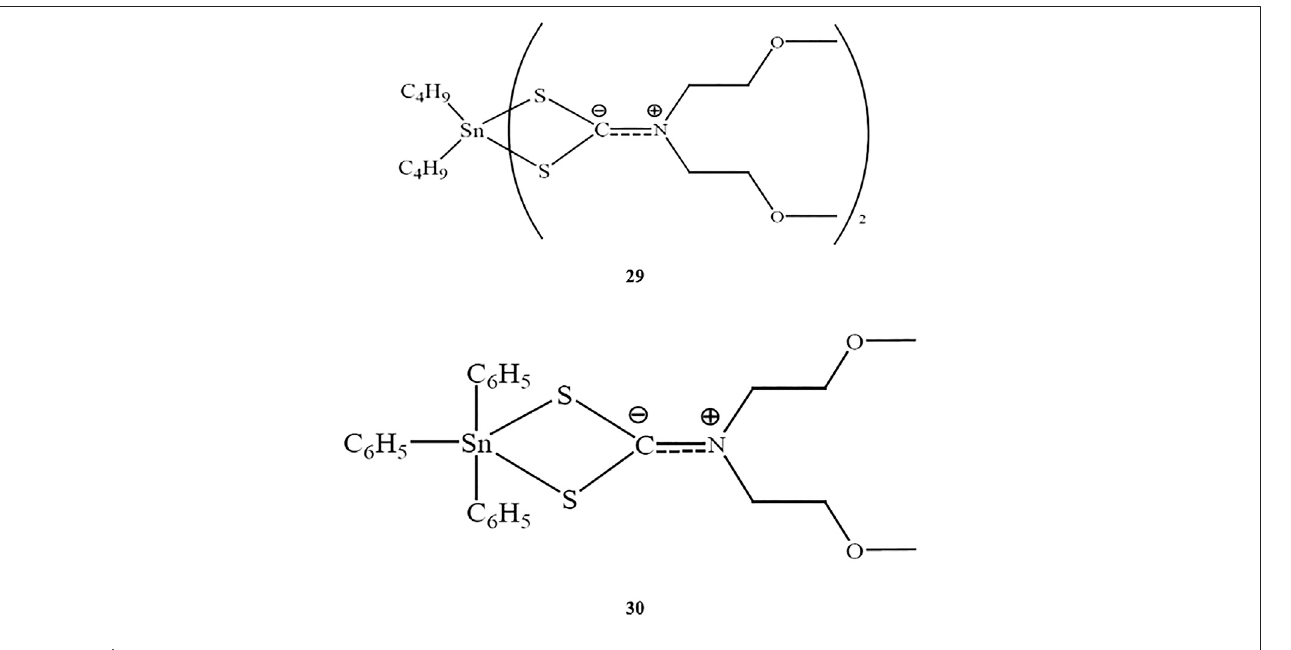
SCHEME 5 | Chemical structures of the ligands and the atom numbering scheme.